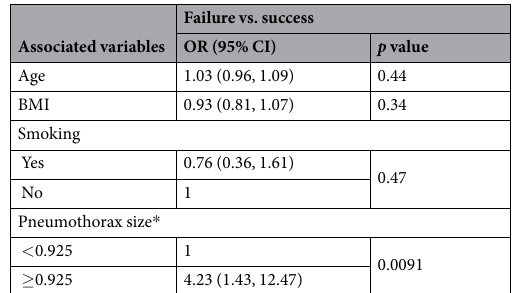
Table 3. Multivariate logistic regression analysis of risk factors. * The alternative cut-off value of pneumothorax size was defined using the classification and regression tree (CART) method.